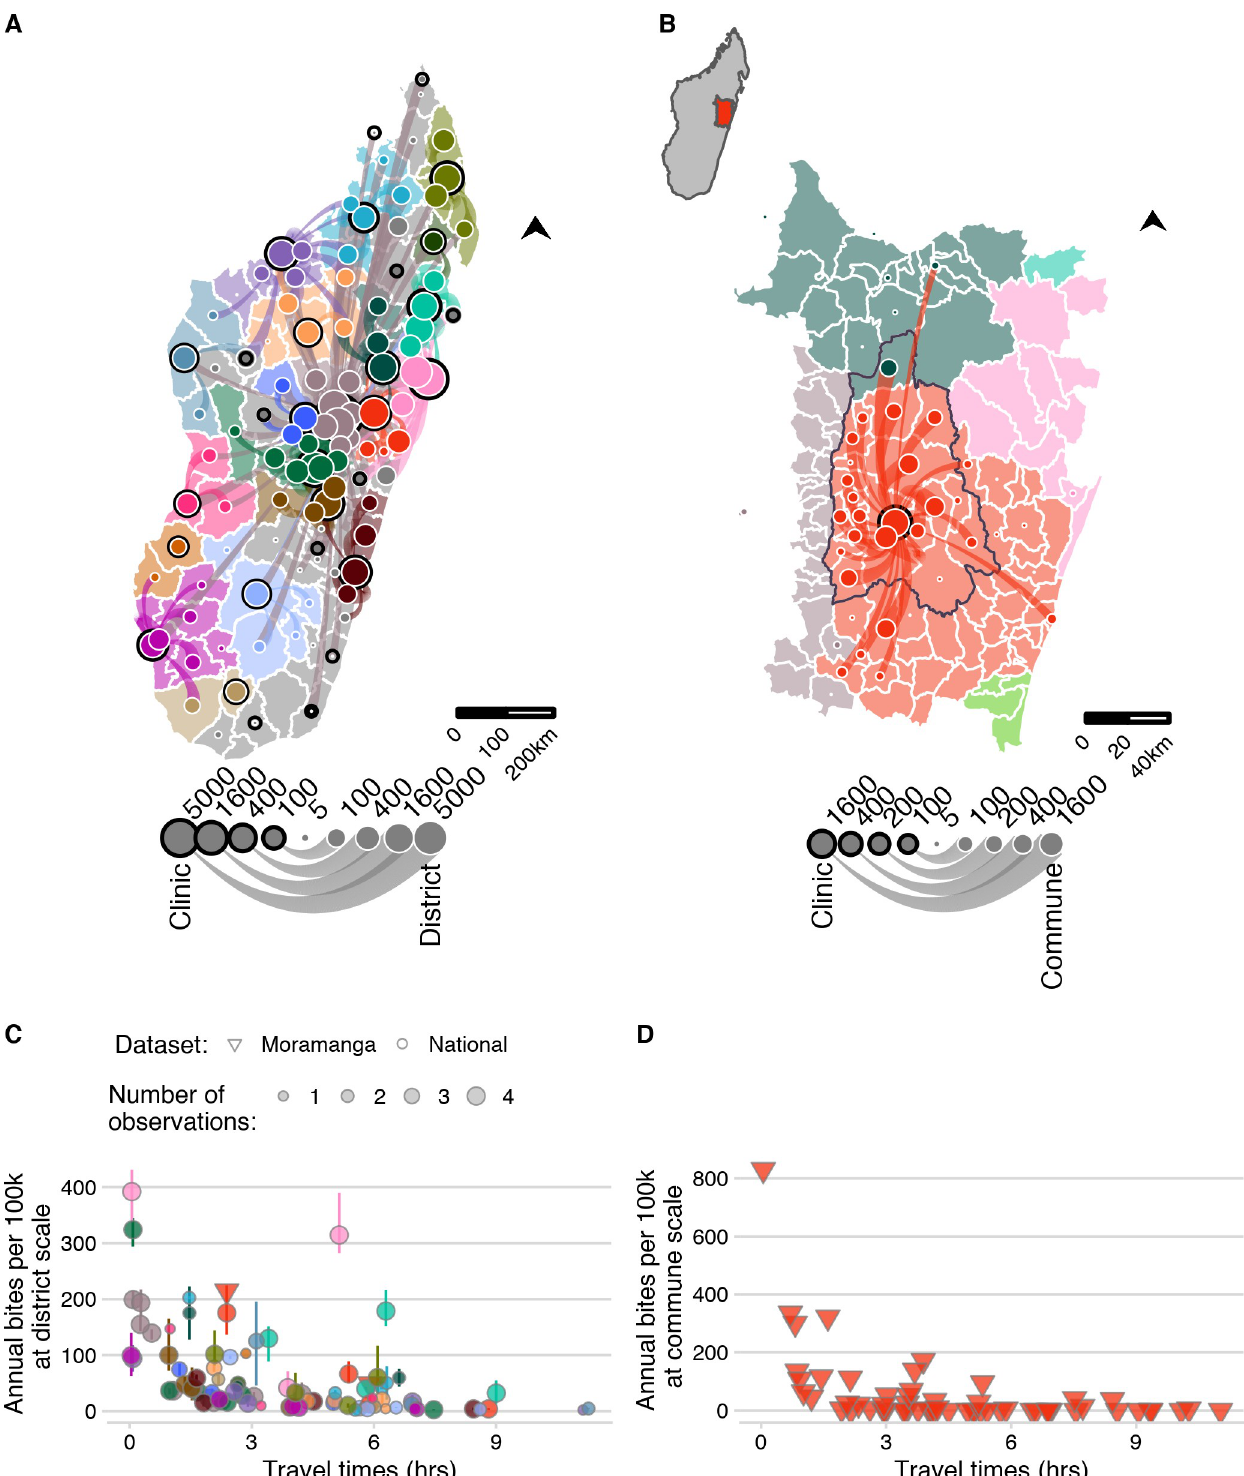
Fig 3. The network of patient presentations and estimates of annual bite incidence. (A) at the district level for the national data and (B) commune level for the Moramanga data: circles with a black outline represent the total number of patients reporting to each clinic for which we have data. Color corresponds to the clinic catchment. Circles with a white outline are the total number of bites reported for that administrative unit (plotted as the centroid). Lines show which clinic those patients reported to, with the line width proportional to number of patients from that district reporting to the clinic; flows of